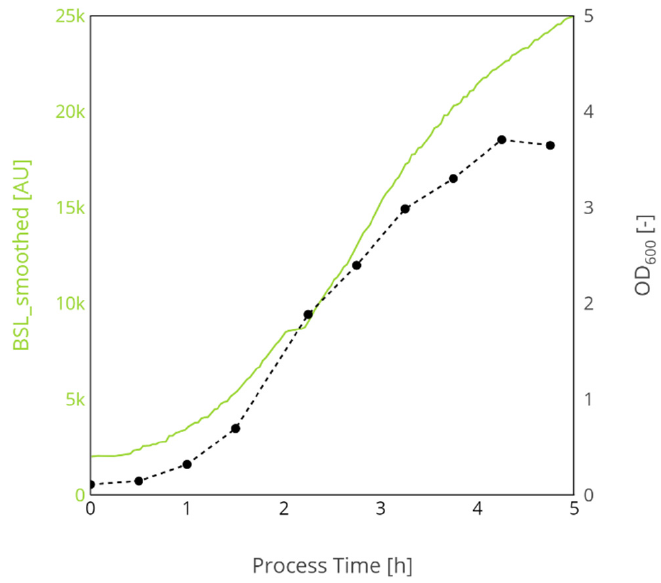
Figure A1. Offline growth data of E. coli W3110 in LB medium. The difference in increase between offline and online measured biomass concentration in the absence of calibration leads to significant differences in the calculated growth rate (µ offline = 1.323 h − 1 compared with µ BSL, auto. = 0.7561 h − 1 ).